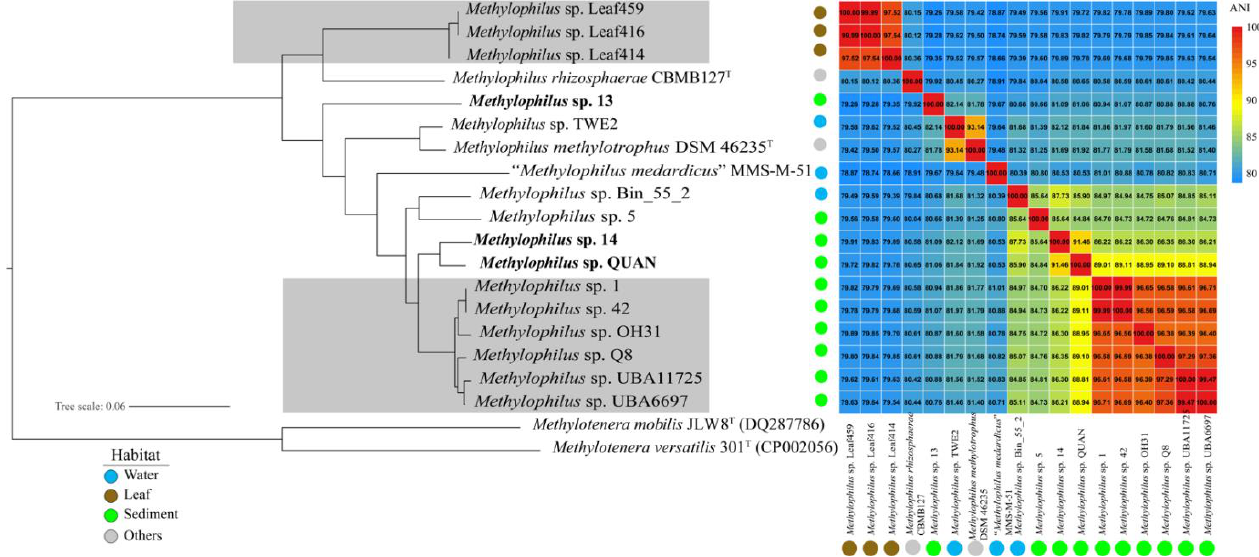
Figure 2. Phylogenomic tree based on 1035 single-copy genes with Methylotenera versatilis 301 T and Methylotenera mobilis JLW8 T as the outgroup and ANI heatmap. The positions of the 18 strains of genus Methylophilus and 2 type strains of genus Methylotenera were shown in the phylogenomic tree based on the comparative sequence analysis (1,035 single-copy genes). Three newly isolated methylotrophic strains ( Methylophilus sp. 13, 14 and QUAN) were highlighted with bold. The clades belonging to the same species were highlighted with grey according to ANI results (ANI values larger than 95%), respec- tively. The solid circles with colors, blue, brown, green and grey, represent isolation sources, water, leaf, sediment and others, respectively. The tree scale (0.06) indicated the number of substitutions per amino acid position. Cells in the heatmap consistent with different ANI values were represented by different color scales.